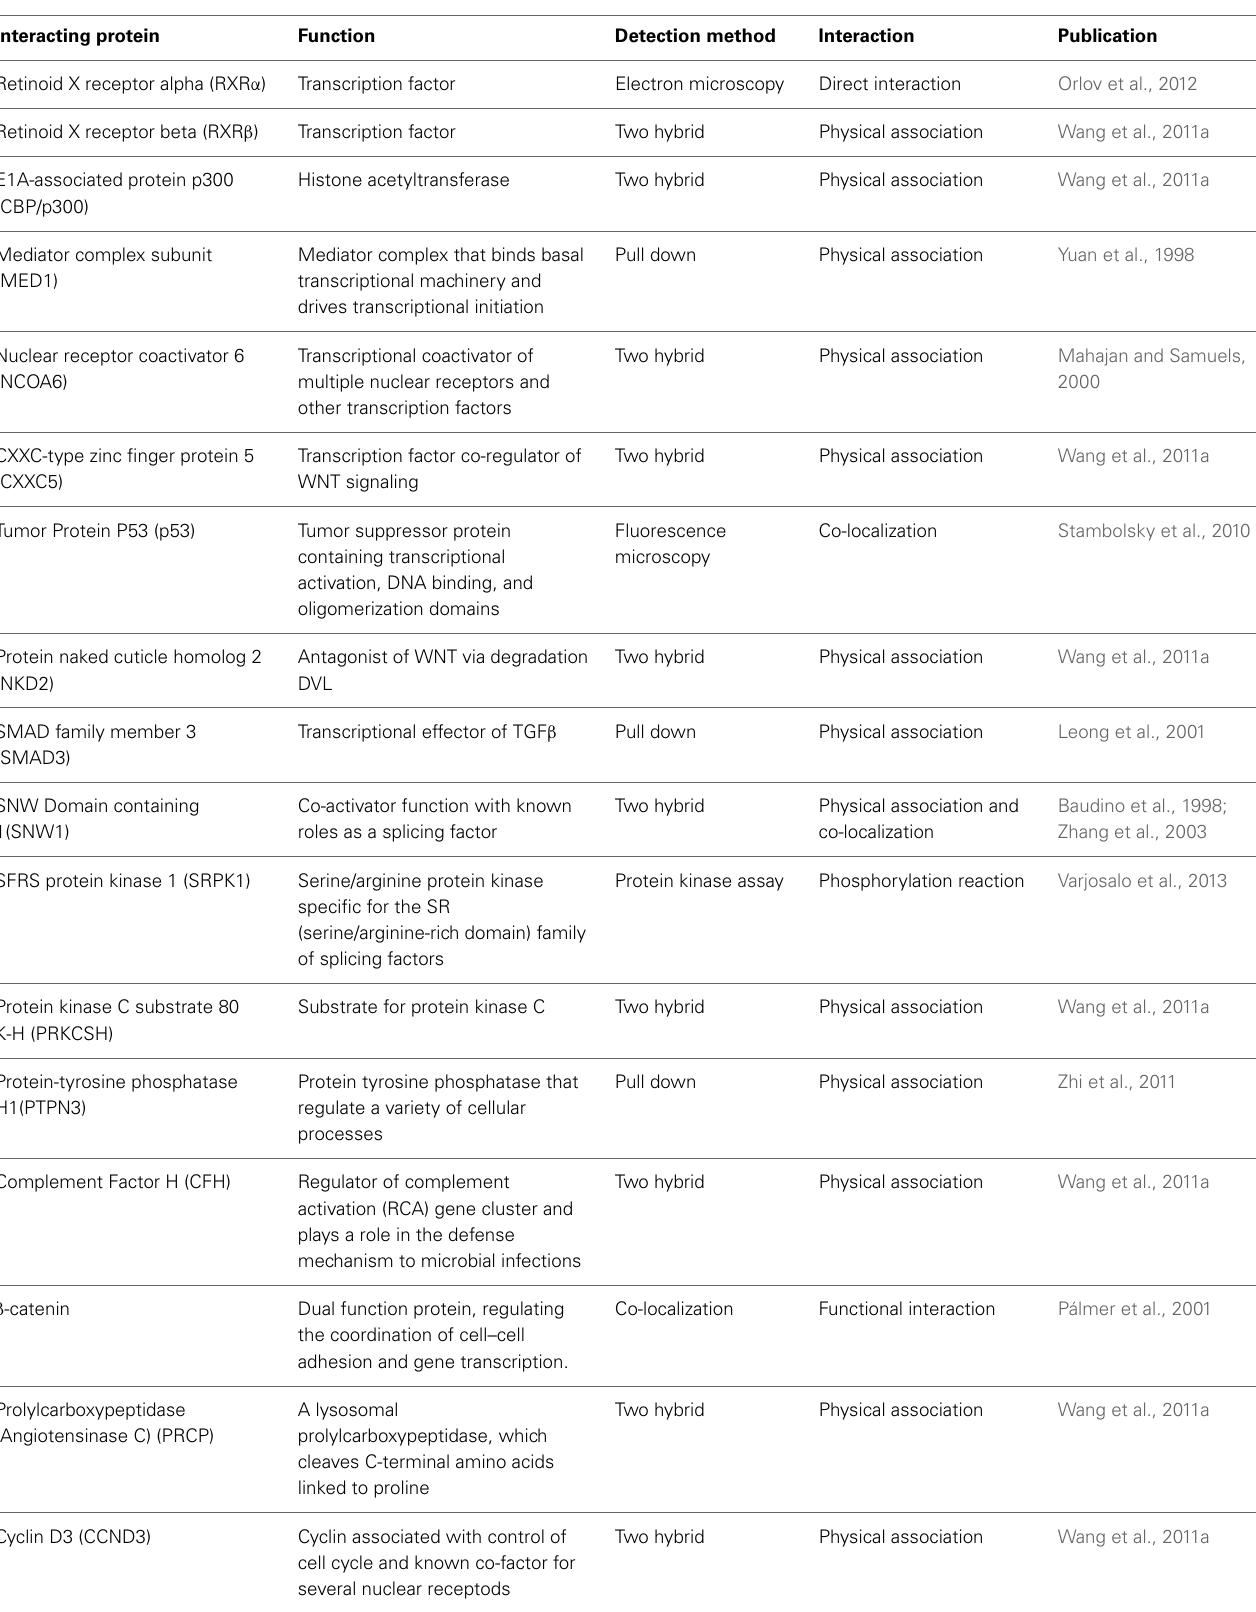
Table 1 | Proteins known to interact with the